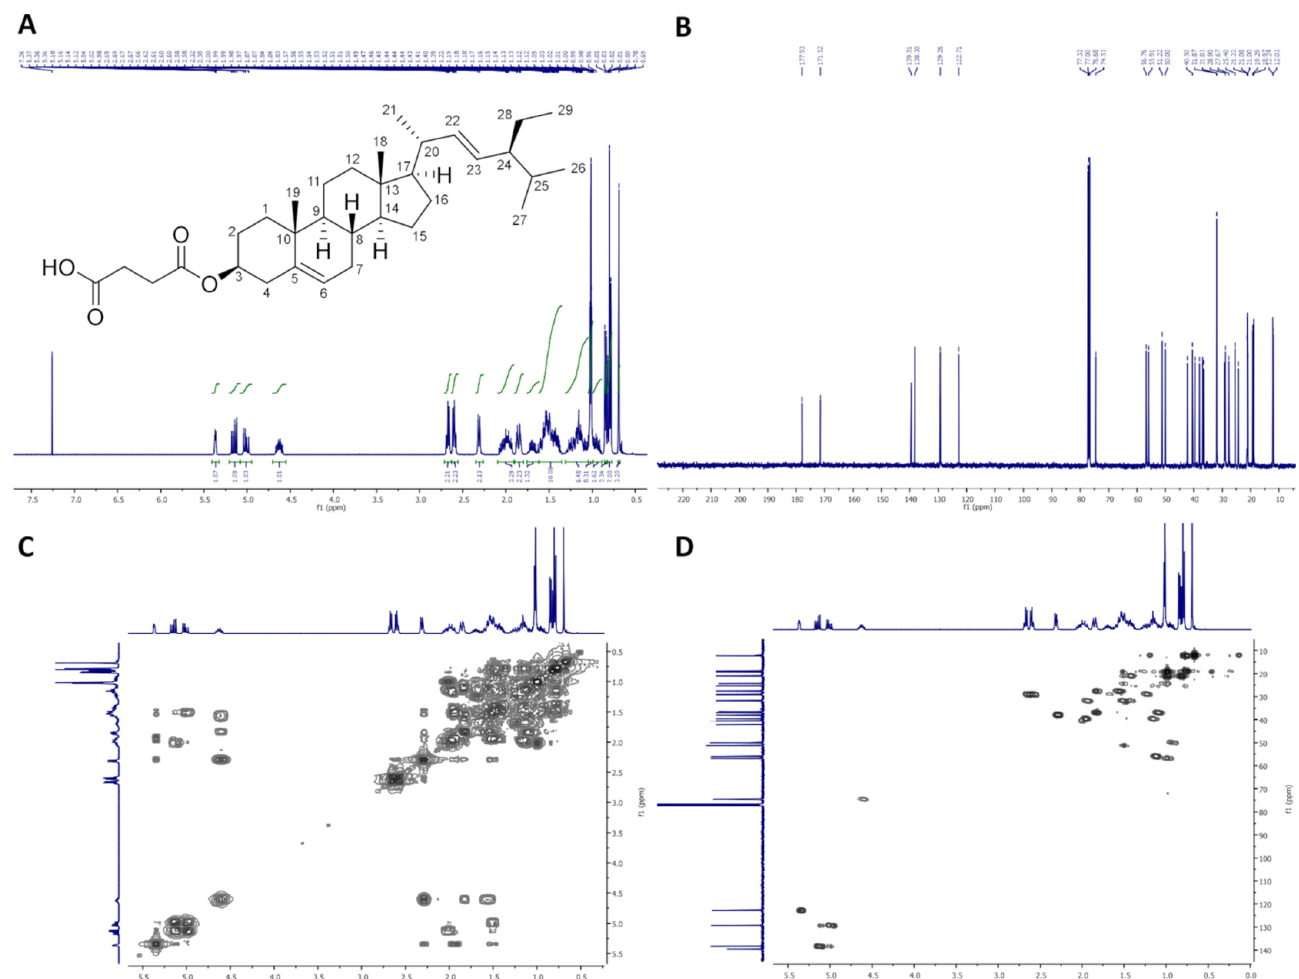
Figure 1. NMR spectra of StigHS: ( A ) 1 H-NMR (400 MHz, CDCl 3 ), ( B ) 13 C-NMR (100 MHz, CDCl 3 ), ( C ) COSY and ( D ) HMQC.